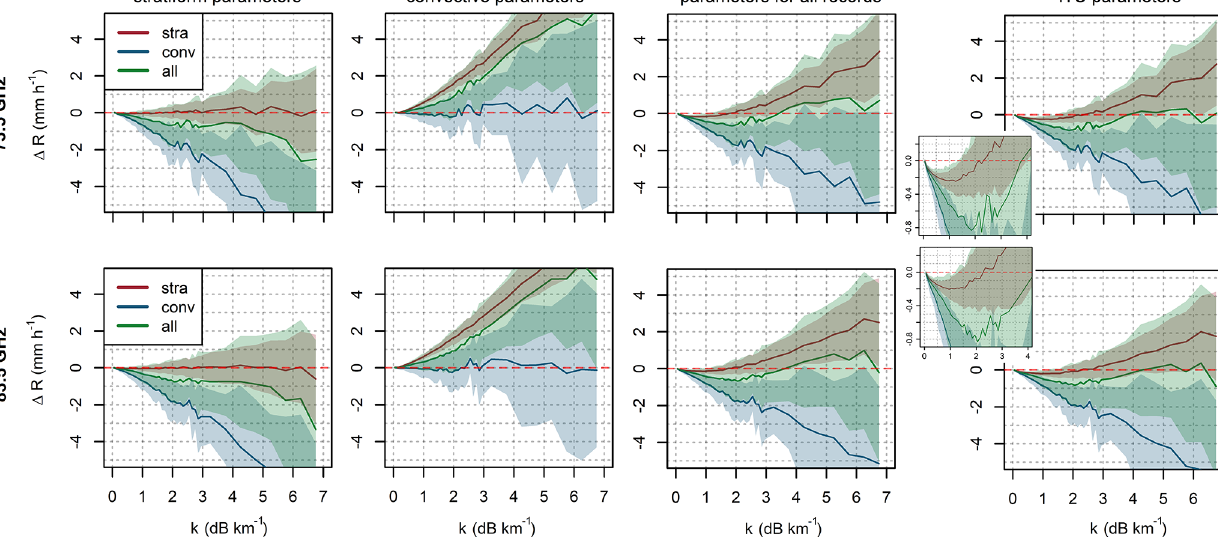
Figure 4. Systematic deviation of the k – R models with different parameters from mean rainfall intensities when applied to (i) stratiform, (ii) convective, and (iii) all the rainfalls together. Random errors are depicted by bands corresponding to ± 1 standard deviation of rainfall intensities in a given bin. Insets show ITU model performance for the specific attenuation range of 0–4dBkm − 1